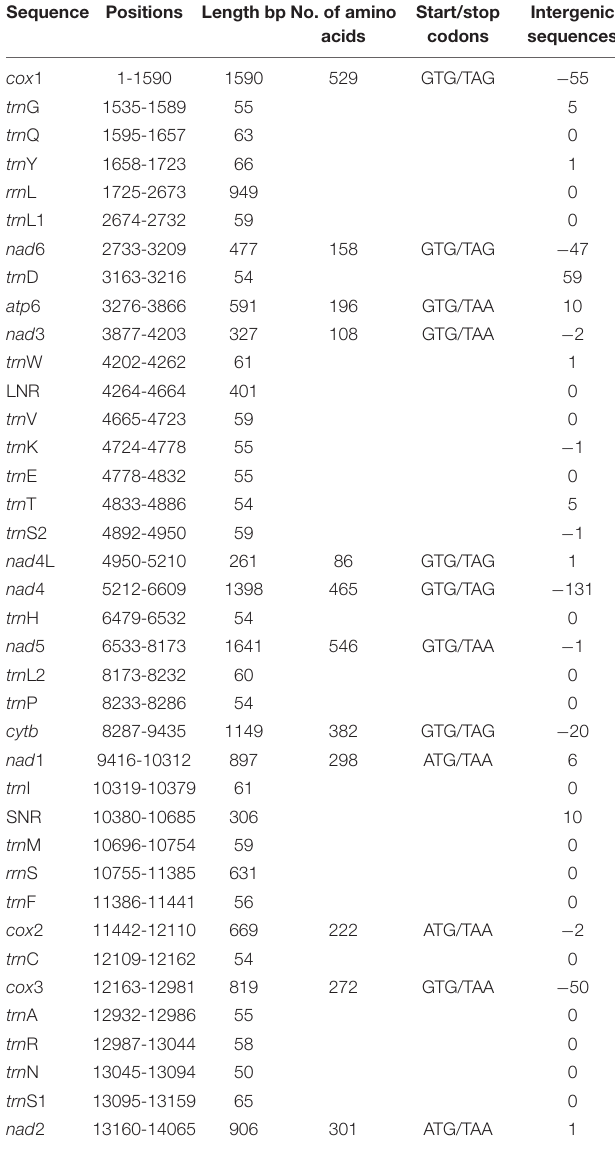
TABLE 2 | Organization of the mitochondrial genome of Moniliformis sp. XH-2020. Sequence Positions Length bp No. of amino